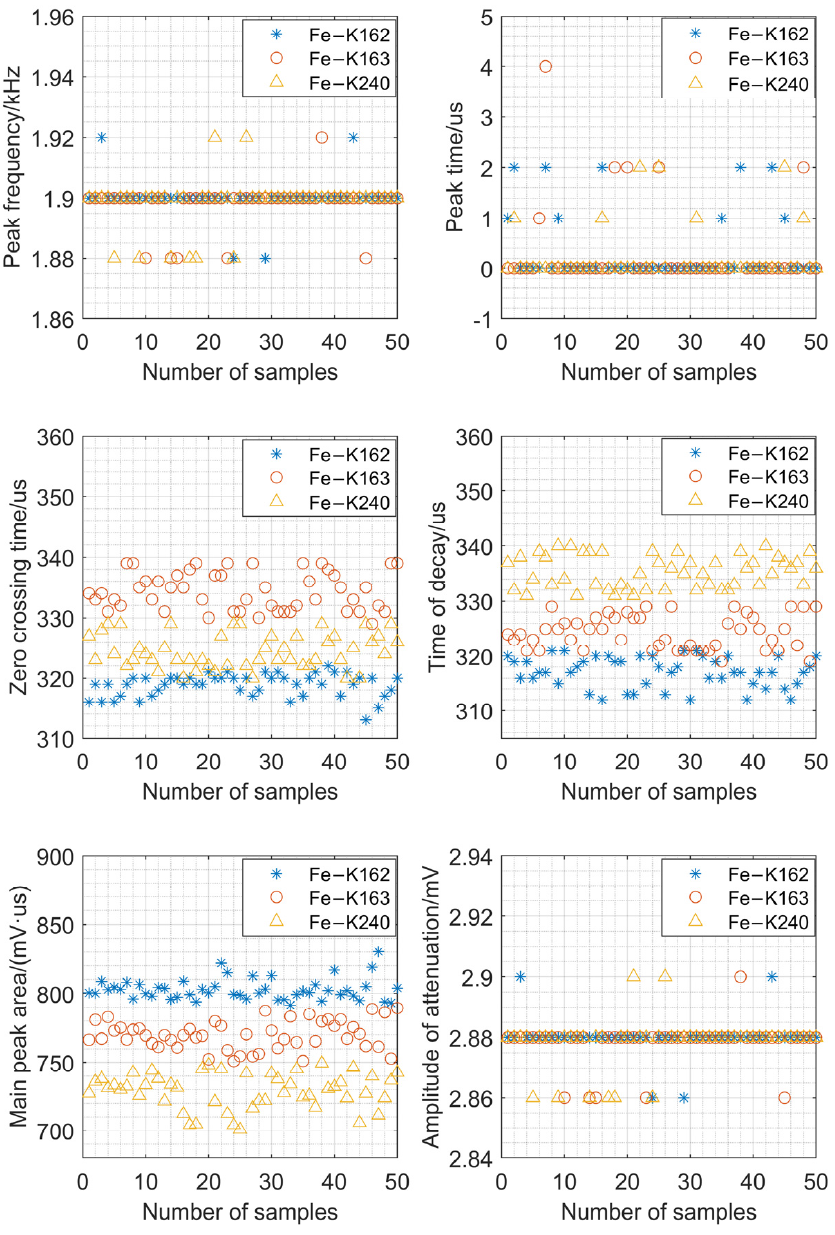
Figure 5. Signal characteristic distribution of Fe-K162, Fe-K163 and Fe-K240.